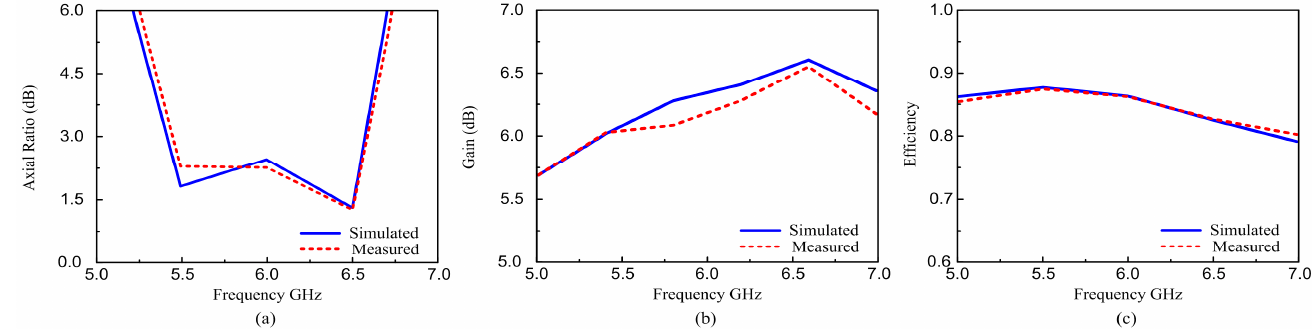
Figure 11. Simulated and measured axial ratio, gain, and total efficiency of the proposed antenna: ( a ) Axial ratio; ( b ) Gain; ( c ) Radiation